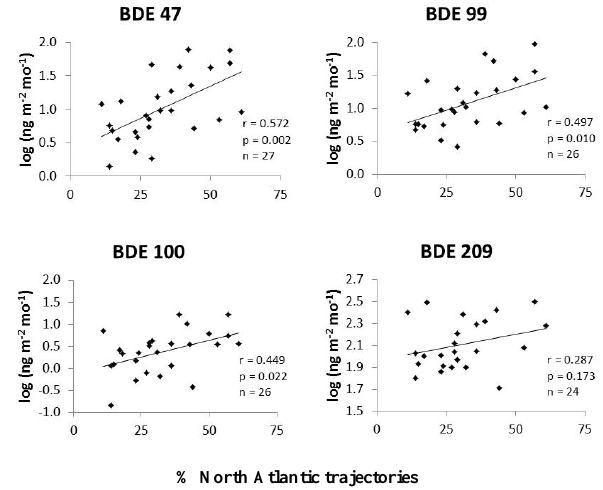
Fig. 6. Relationship between % of North Atlantic air masses during the collection period of each sample and PBDE atmospheric depo- sition fluxes in